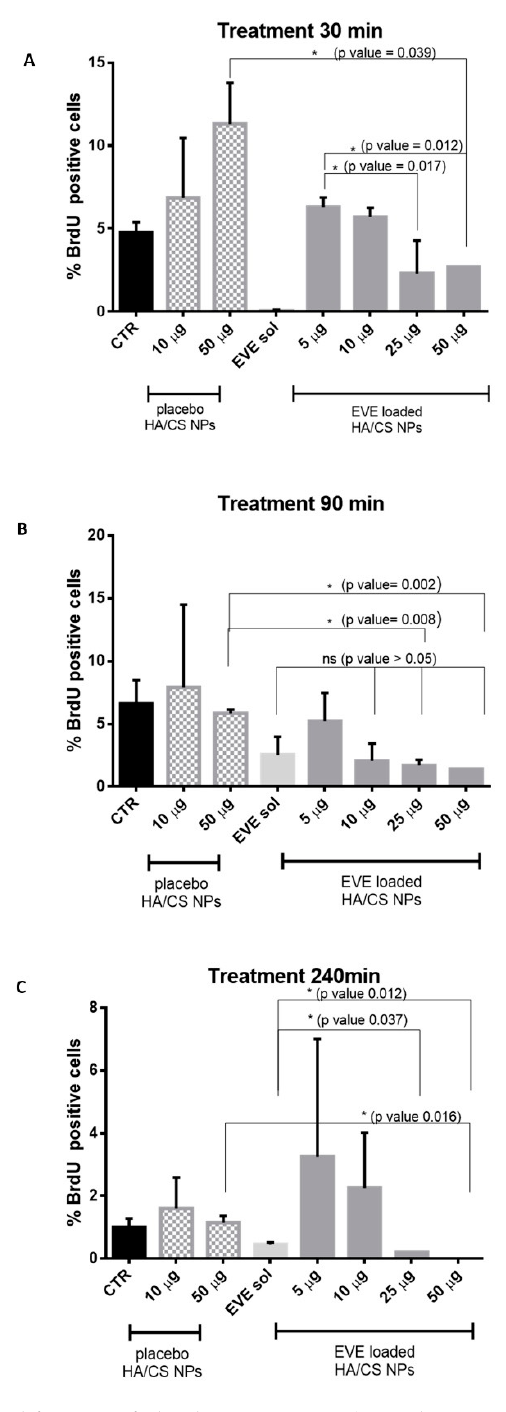
Figure 6. E ff ect on cell proliferation of placebo HA / CS NPs (10 and 50 µ g / 20,000 cells), EVE solution Figure 6. Effect on cell proliferation of placebo HA/CS NPs (10 and 50 μ g/20,000 cells), EVE solution (EVE sol, 2.2 µ g / 20,000 cells) and EVE loaded HA / CS NPs after 30 min ( A ), 90 min ( B ) and 240 min ( C ) (EVE sol, 2.2 μ g/20,000 cells) and EVE loaded HA/CS NPs after 30 min ( A ), 90 min ( B ) and 240 min of ( C ) of treatment.